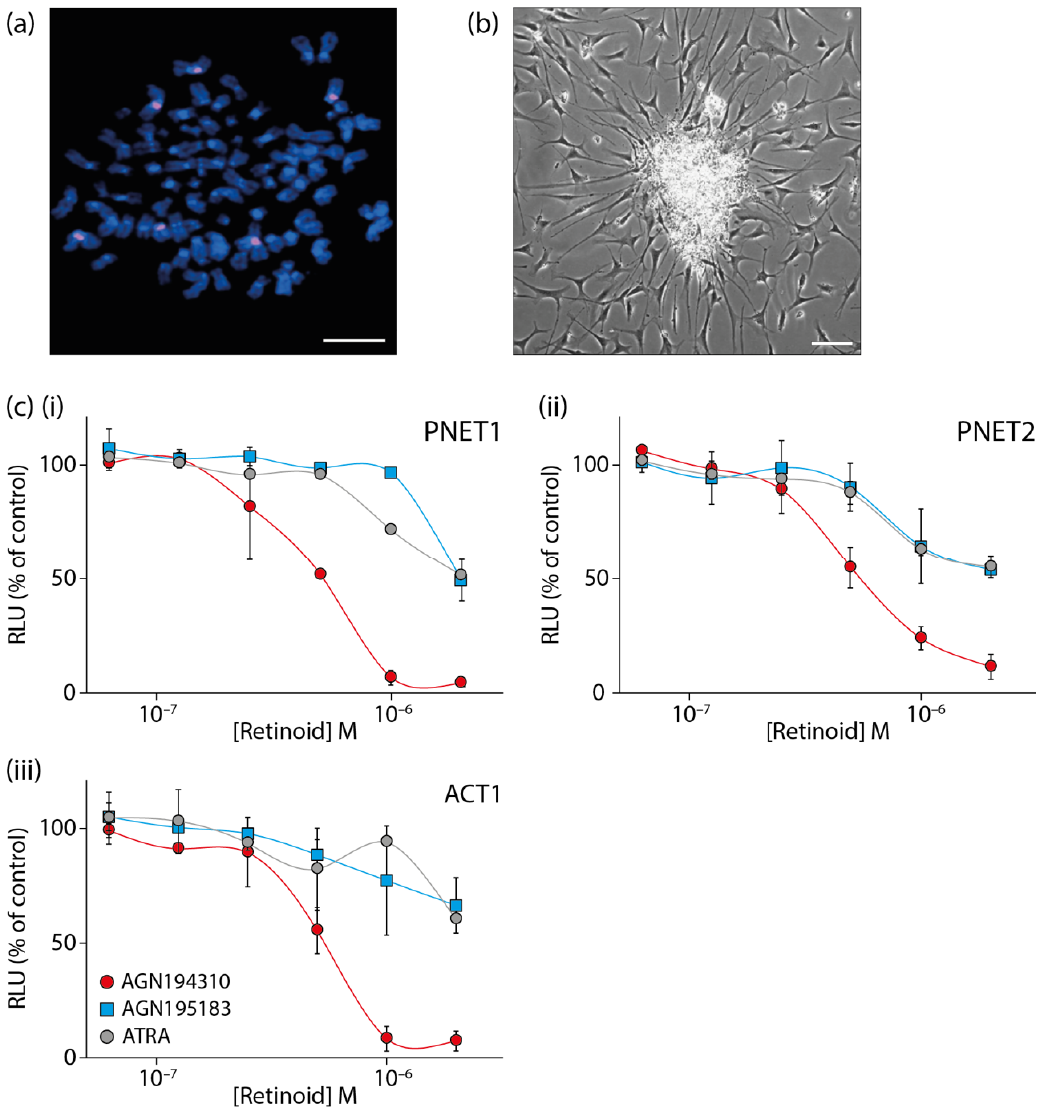
Figure 2. The pan-RAR antagonist AGN194310 ablates primary cells grown from pediatric primitive neuroectodermal tumor biopsies. ( a ) Metaphase fluorescence in situ hybridization (FISH) of a single cell stained with a probe (red) for the chromosome 1 centromere (six copies of chromosome 1 are visible). Scale bar = 100 µm. ( b ) Primary culture of cells from a pediatric primitive neuroectodermal tumor biopsy characterized by a neurosphere-like structure with differentiating cells. Scale bar = 100 µm. ( c ) Dose–response curves of cell viability for two primitive neuroectodermal tumors ( i , PNET1) and ( ii , PNET2) and an astrocytoma ( iii , ACT1) following treatment with the pan-RAR antagonist AGN194310, the RARα- selective agonist AGN195183, or ATRA. Cells were plated into microtitre wells and cell viability determined by measuring the level of cellular ATP at day 5. Data are means ± SE of triplicate values from 3 ( i ), 2 ( ii ), and 4 ( iii ) independent experi- ments.